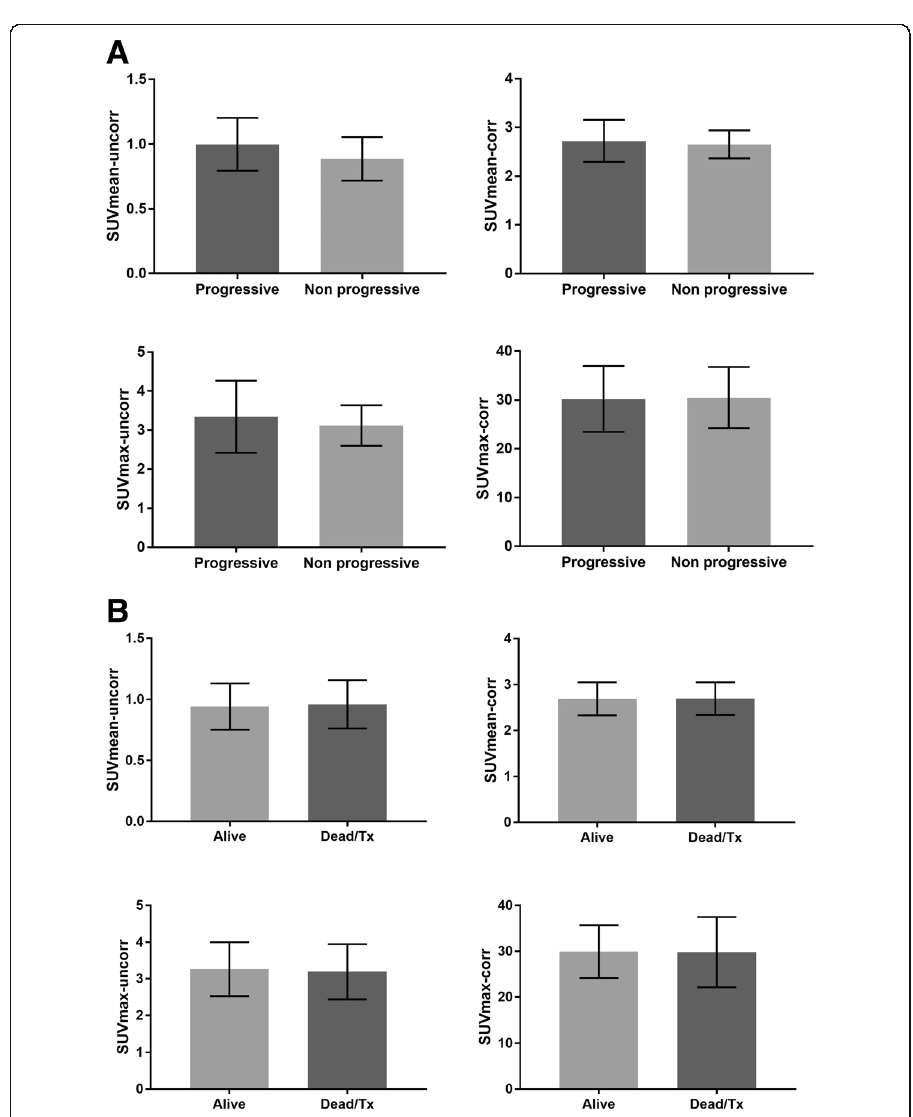
Fig. 5 Comparison between PET/CT values corrected or not for the density and the clinical evolution. Patients were classified according to progressive ( n = 15) or non-progressive ( n = 14) disease ( a ) or to their vital status at the end of the study (alive ( n = 19) vs death or lung transplanted ( n = 12)) ( b ). No significant difference was noticed in all